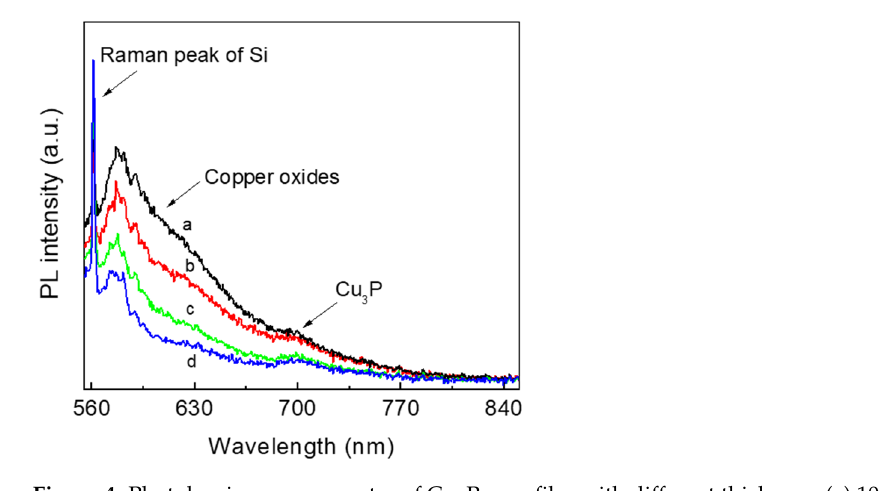
Figure 4. Photoluminescence spectra of Cu 3 P nanofilm with different thickness: ( a ) 10 nm; ( b ) 7 nm; ( c ) 5 nm and ( d ) 4 nm, respectively.